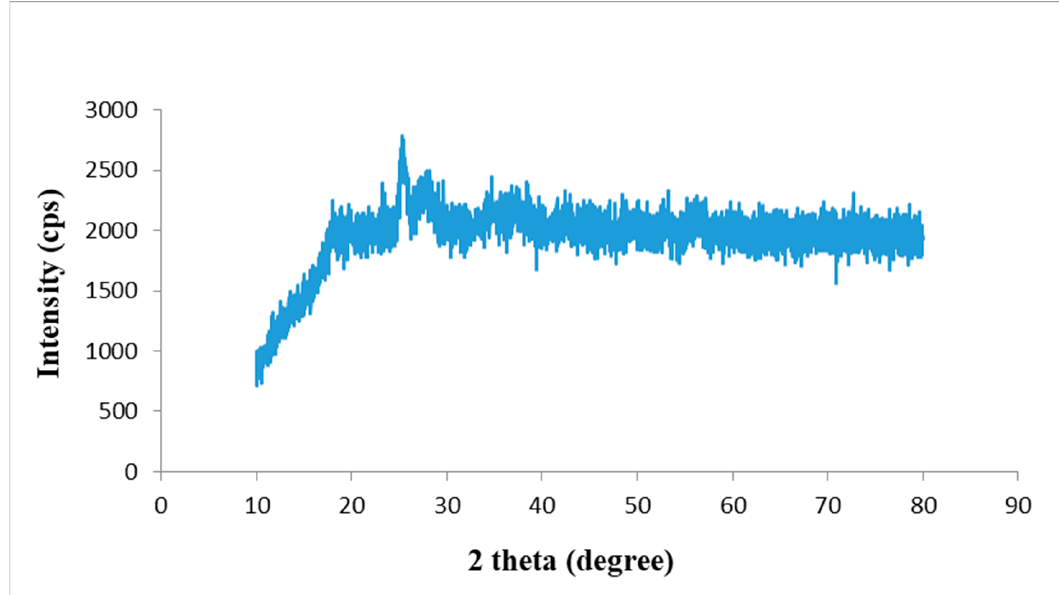
Figure 4. X-ray di ff raction (XRD) of GONS. (GONS = Graphene oxide nanosheets). Figure 4. X-ray diffraction (XRD) of GONS. (GONS = Graphene oxide nanosheets).